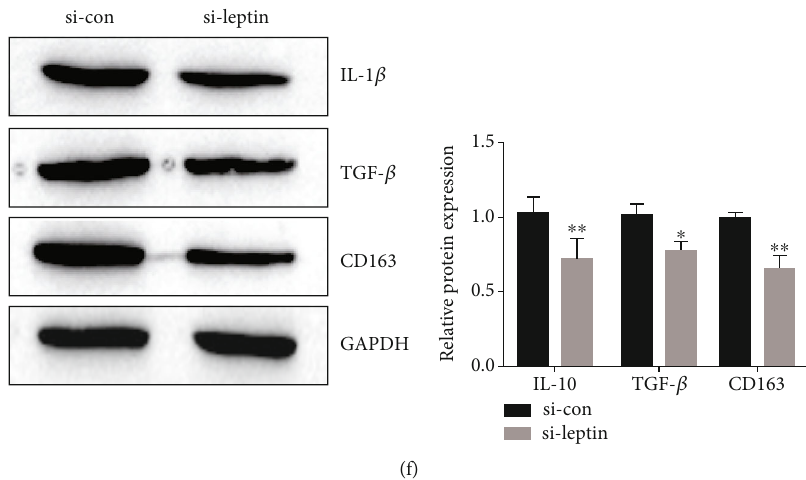
Figure 2: GBC-SD cell-derived exosome-mediated transfer of leptin promotes M2 macrophage polarization. (a) Leptin protein expression in GBC-SD cell derived-exosome was determined by Western blot. (b) The leptin mRNA expression in GBC-SD cell derived-exosome was measured by qRT-PCR. (c) Leptin protein expression in macrophage with PBS or GBC-SD cell-derived exosome-treated was detected by Western blot. The leptin protein expression in macrophage with PBS or GBC-SD cell-derived exosome-treated was quanti fi ed. (d) Western blot assay showed leptin protein expression in macrophage treated with exosomes form si-control or si-leptin-transfected GBC- SD cell. The leptin expression in macrophage treated with exosomes form si-control or si-leptin-transfected GBC-SD cell was quanti fi ed. (e) qRT-PCR to detect the speci fi c markers for M2-subtype macrophages in macrophage treated with exosomes form si-control or si- leptin-transfected GBC-SD cell. (f) Western blot to detect the speci fi c markers for M2-subtype macrophages in macrophage treated with exosomes form si-control or si-leptin-transfected GBC-SD cell. Data in (a – f) are representative of three independent experiments; the P value was determined by Student ’ s t